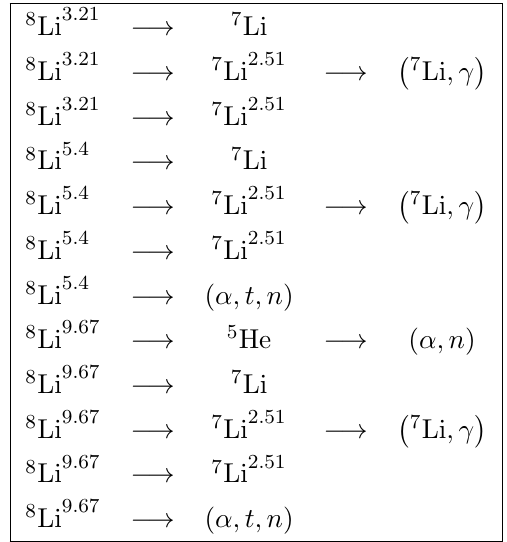
Table 4 . 8 Li decay paths relevant after the (cid:12) -decay of 8 He. The energy levels (in MeV) relative to the ground state of 8 Li are indicated as superscripts of the chemical elements; when no superscript is present, the ground state of the considered nucleus must be